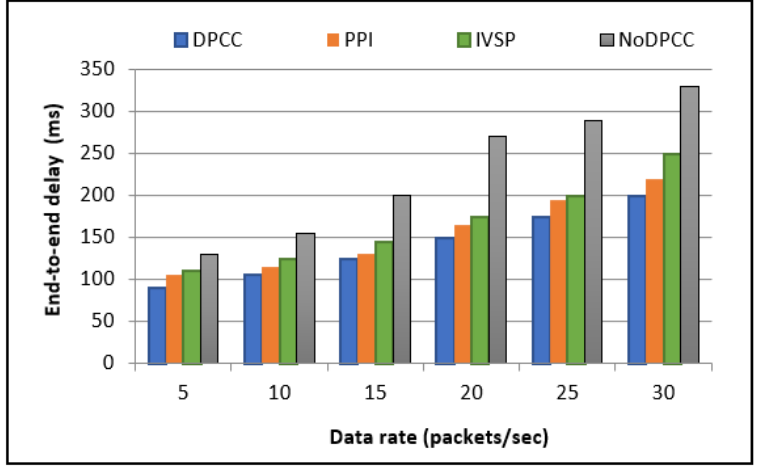
Figure 13. Average end-to-end delay vs. data rate.